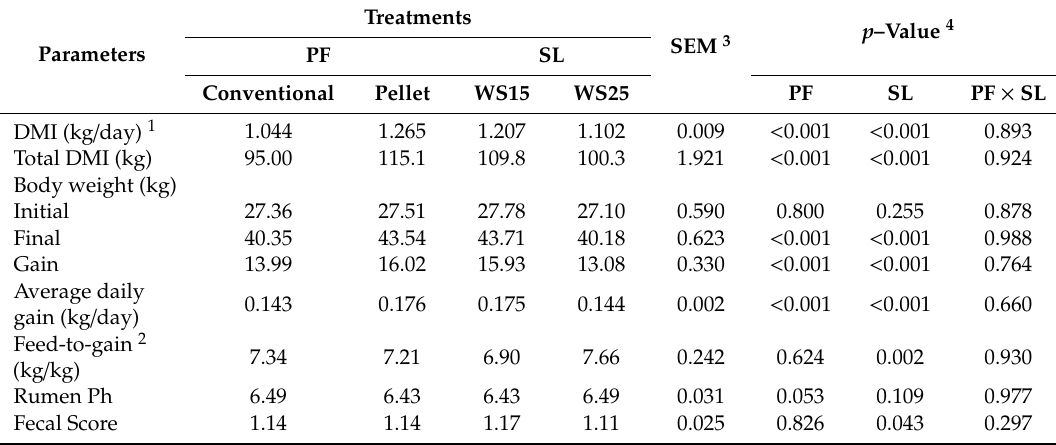
Table 3. Growth performance, feed-to-gain ratio, rumen pH, fecal score, and structural measurements in fattening goats fed conventional and pelleted total mixed ration.